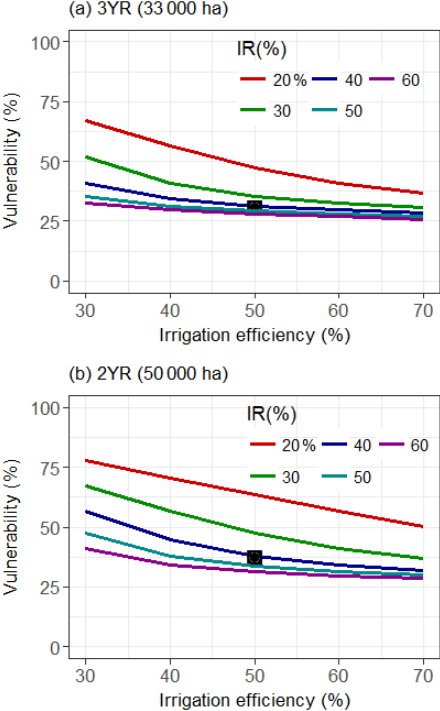
Figure 9. Mean vulnerability vs. irrigation efficiency (IE) at differ- ent levels of intake ratio (IR) of the 3- and 2-year rotation systems (the black square indicates typical values of IR and